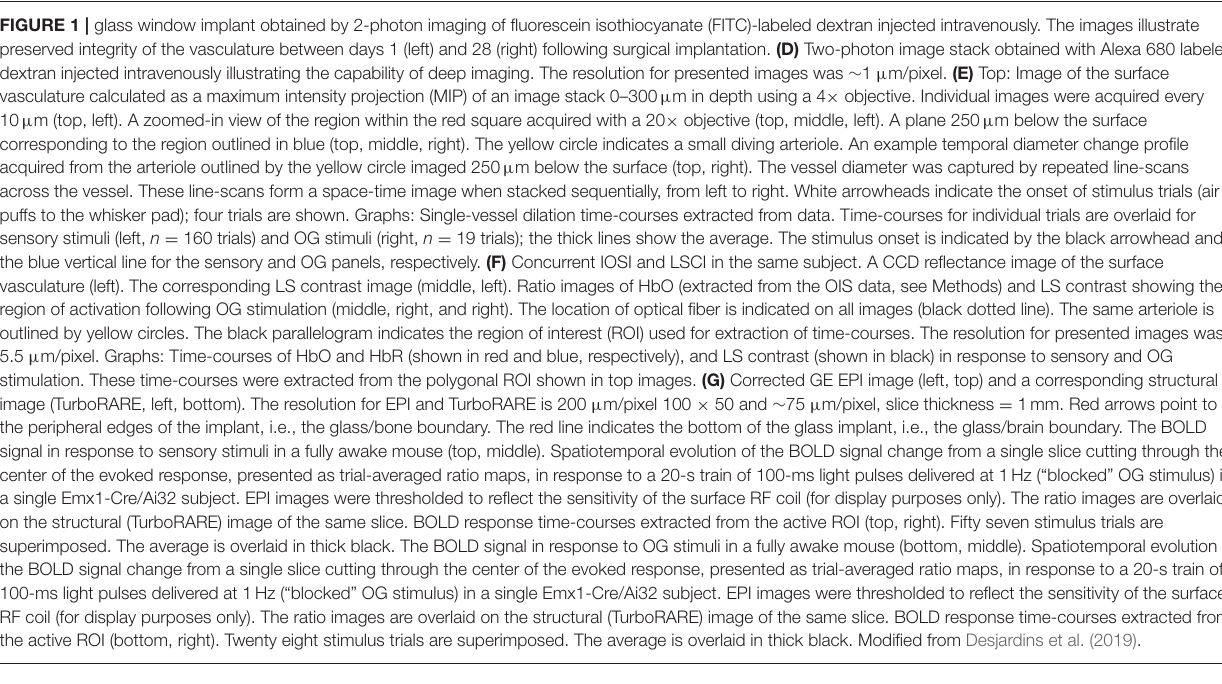
with alcohol and, if necessary, it can be gently scraped with a blade. Soft polymer windows should not be treated with